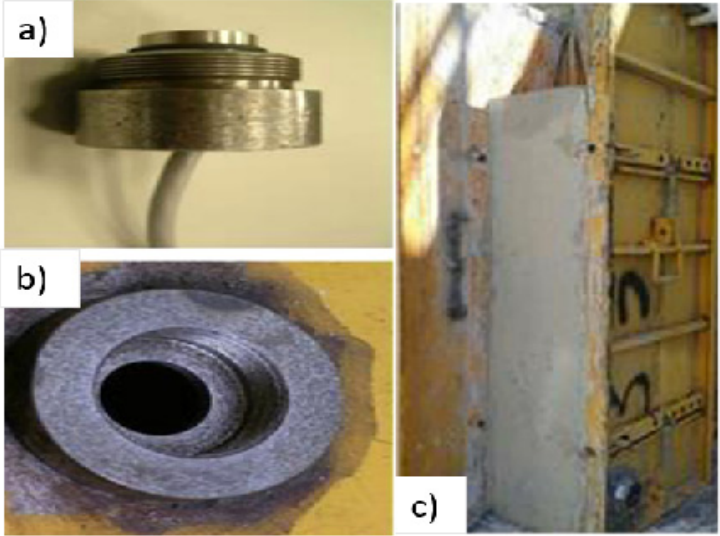
Figure 7. Laboratory setup with steel formwork ( a ) pressure sensor; ( b ) welded pressure diaphragm ( c ) formwork setup [40] (reprinted with permission from © 2021 Elsevier Ltd.).